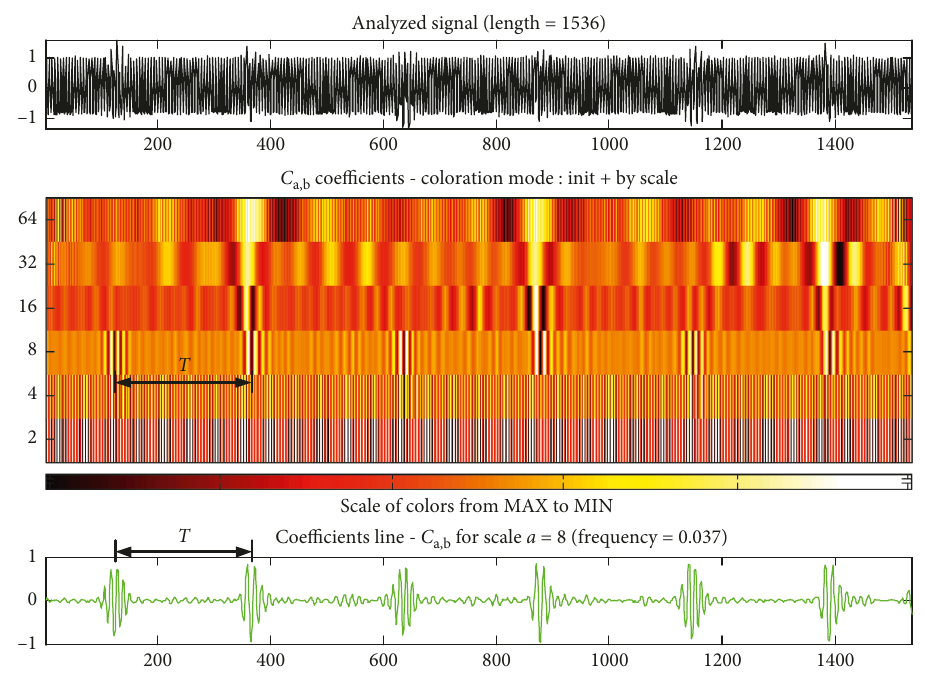
Figure 12: The time-frequency diagram of acceleration for the roller bearing lack of one roller.